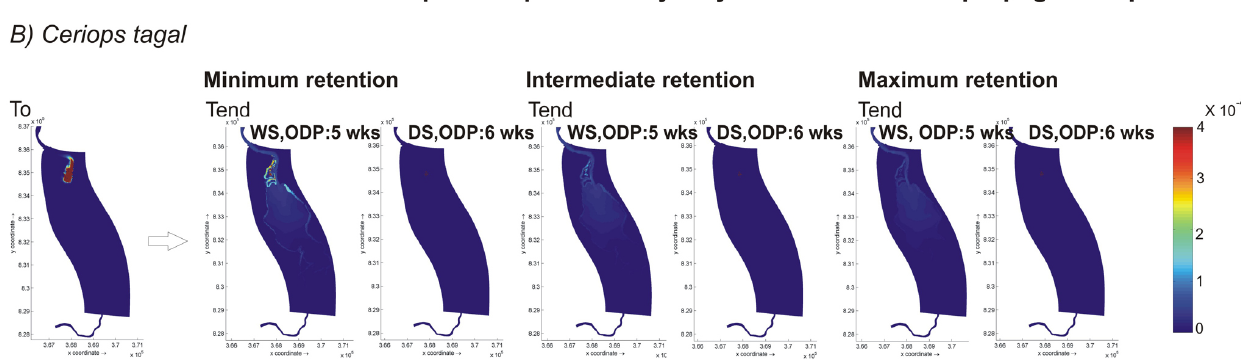
Fig. 5b. Results of scenario 1 (effect of species-specific buoyancy) showing the distribution plots of Ceriops tagal . WS = wet season, DS = dry season, ODP = obligated dispersal period. Red, yellow and light blue colours indicate a high, medium and low concentration of propagules respectively.